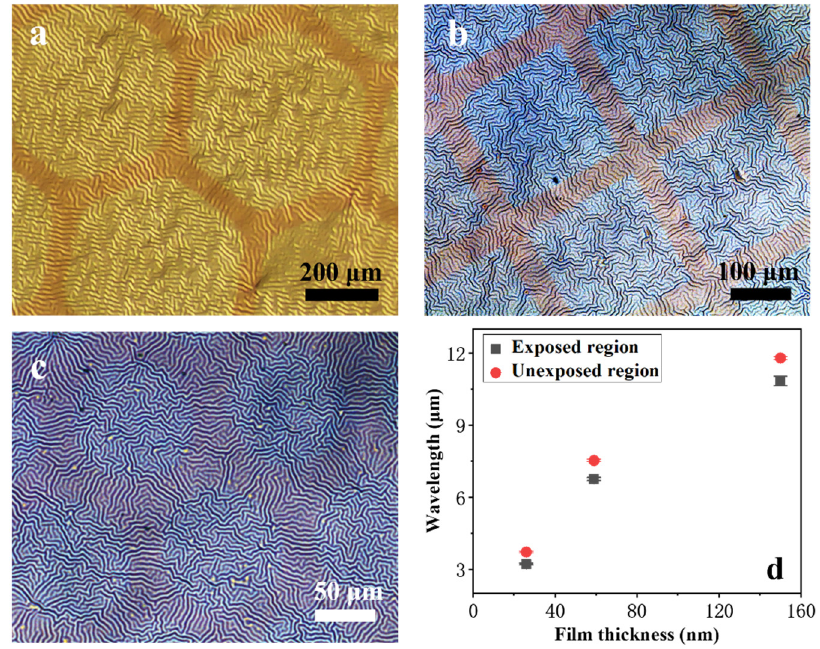
Figure 4. Optical micrographs of wrinkles induced by exposing the (3% PDO 3 -1% PS)/PDMS bilayer with different h f to a high-intensity laser light (e.g., 5.2 W·cm − 2 /30 s) with different copper grids: ( a ) h f = 150 nm with H50 type of copper grid, ( b ) h f = 59 nm with S100 type of copper grid, and ( c ) h f = 26 nm with R200 type of copper grid. ( d ) The dependence of the wrinkle wavelength on the film thickness (e.g., 5.2 W·cm − 2 /30 s/H50).